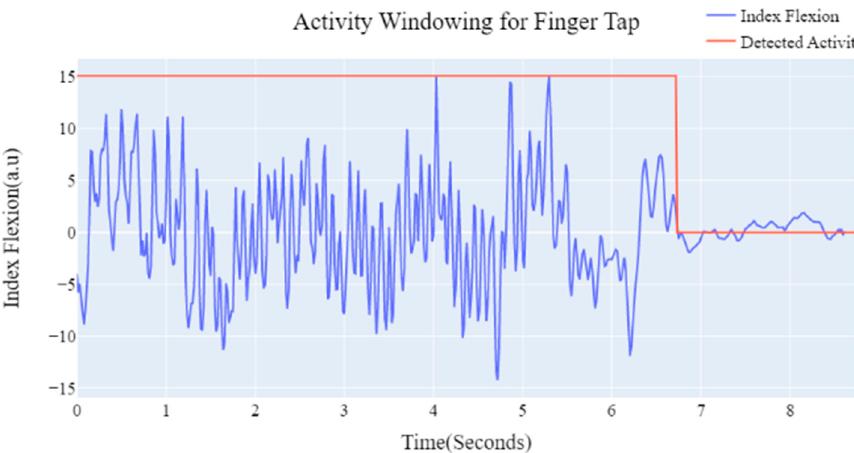
Figure 8. Adaptive activity windowing example for finger tap task.